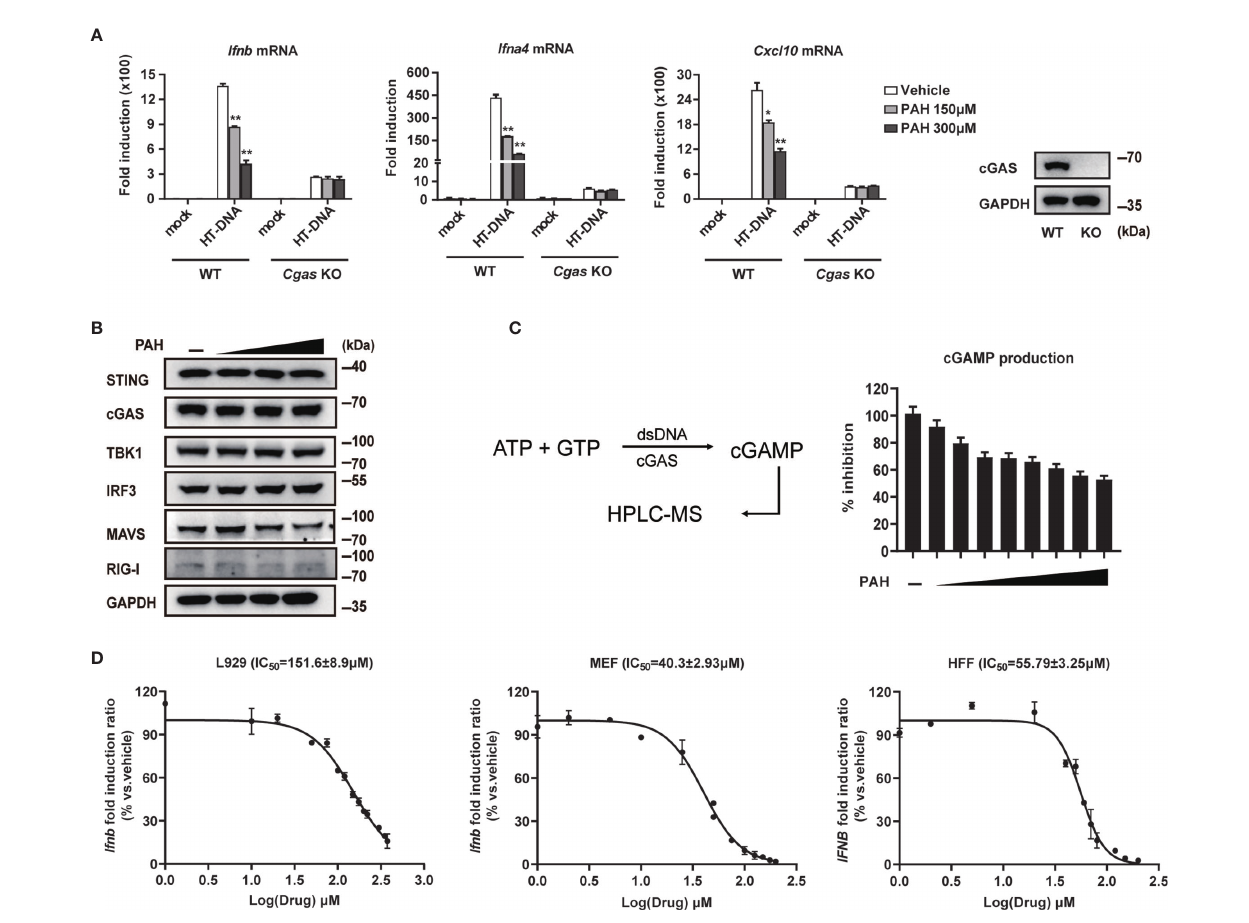
FIGURE 2 | PAH directly inhibits cGAS activity. (A) WT or Cgas -de fi cient L929 cells were treated with Vehicle or PAH for 6 h and then stimulated with HT-DNA (4 m g (cid:129) ml − 1 ) for 6 h. The induction of Ifnb , Ifna4 , and Cxcl10 mRNA expression was then measured by qPCR (left panel). The cGAS protein levels were examined by immunoblot (right panel). (B) L929 cells were treated with a Vehicle or different PAH doses (0 to 300 m M) for 6 h, and then the cell lysates were immunoblotted with the indicated antibodies. (C) Schematic of dsDNA-dependent cGAS synthesis of cGAMP and measurement by HPLC-MS (left panel). The cGAMP production was measured in the presence of a Vehicle or different PAH doses (0 to 40 m M) (right panel). (D) L929, MEF, and HFF cells were treated with indicated concentrations of PAH for 6 h, followed by stimulation with HT-DNA for 6 h. The induction of Ifnb mRNA expression was then measured by qPCR. All of the experiments were repeated at least three times. Data in (A, C, D) are presented as mean ± SD. * P < 0.05, ** P <